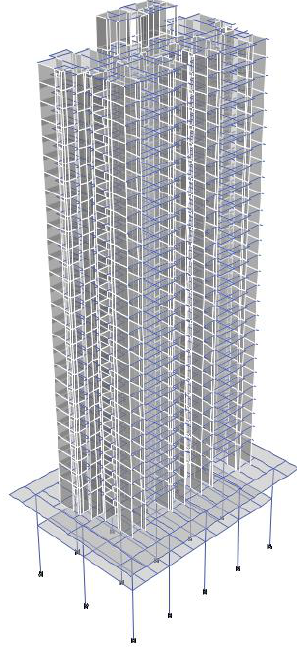
Figure 1. Original structure modeling.